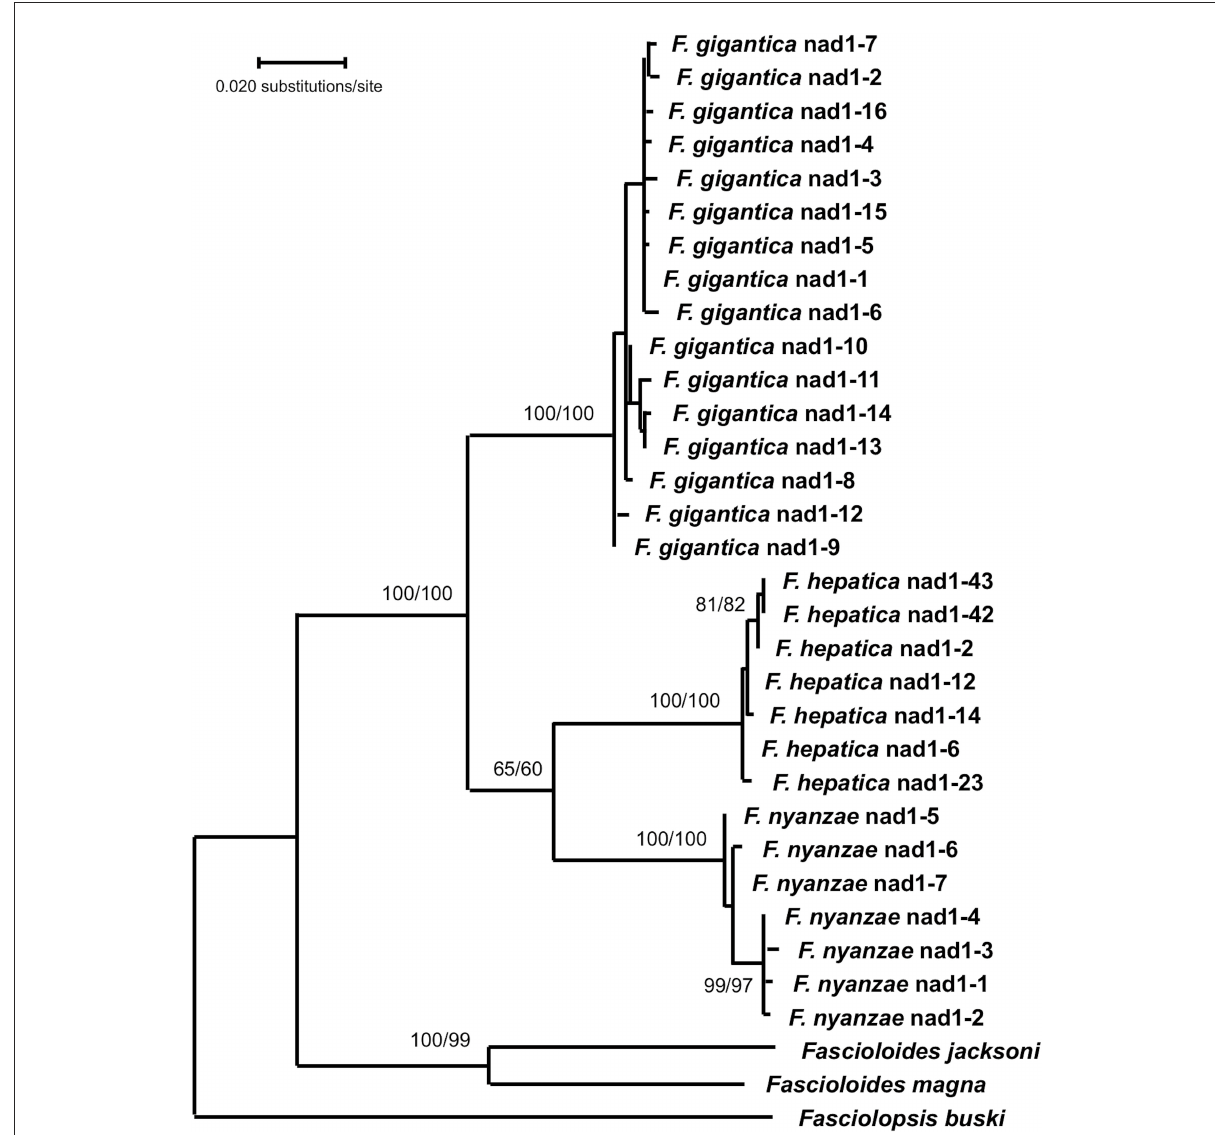
FIGURE5 Phylogenetic tree of species of Fasciola and Fascioloides based on maximum-likelihood (ML) estimates and reconstructed on mtDNA nad 1 sequences (LnL = − 3559.05). The tree is drawn to scale, with branch lengths measured in the number of substitutions per site. The tree was rooted using the sequence of Fasciolopsis buski (MF287793) as outgroup. Supports for nodes a/b using MEGA X: a, bootstrap (1,000 replicates) with ML parameters (T92 + G); b, bootstrap (1,000 replicates) with NJ and Tamura 3-p